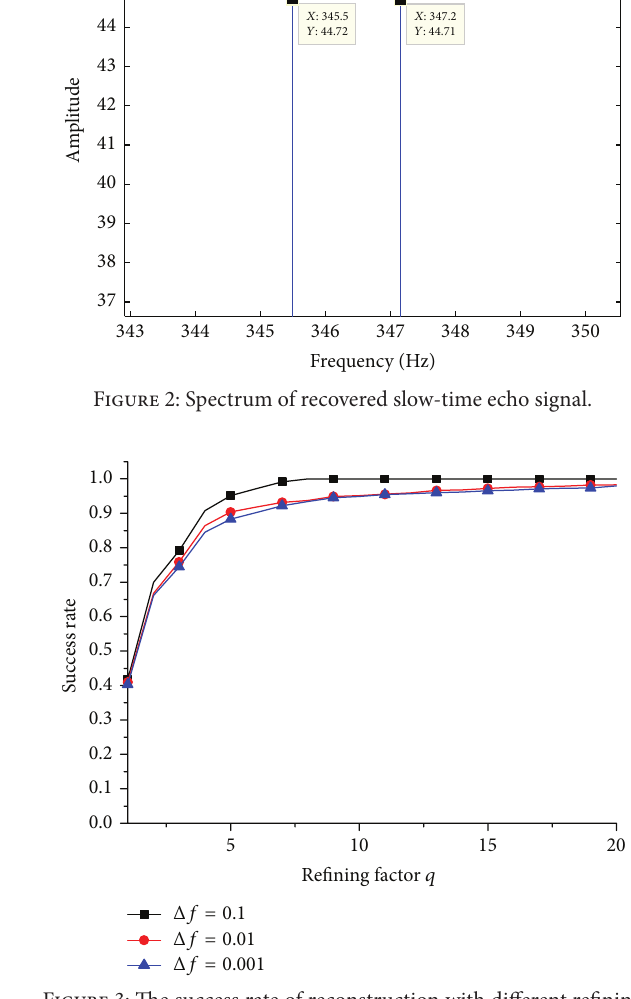
Figure 3: The success rate of reconstruction with different refining factor. Table 1: Comparison of simulation times versus different refining